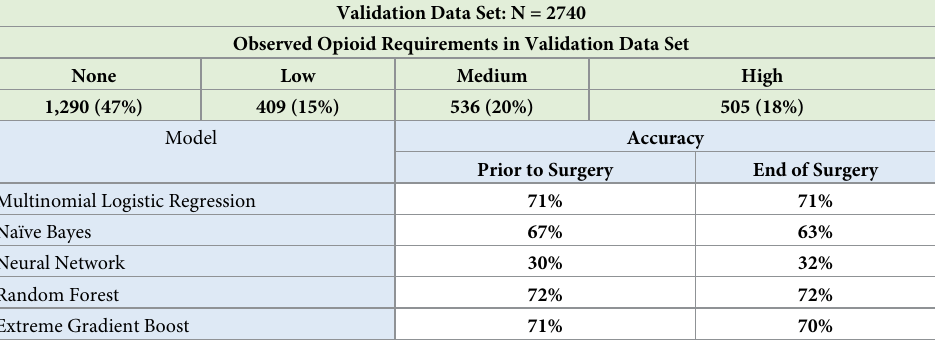
Table 4. Prediction accuracies of different models prior to surgery and at the end of surgery are presented. The models utilized preoperative factors for predictions prior to surgery while the end of surgery predictions used both pre- operative and intraoperative factors.